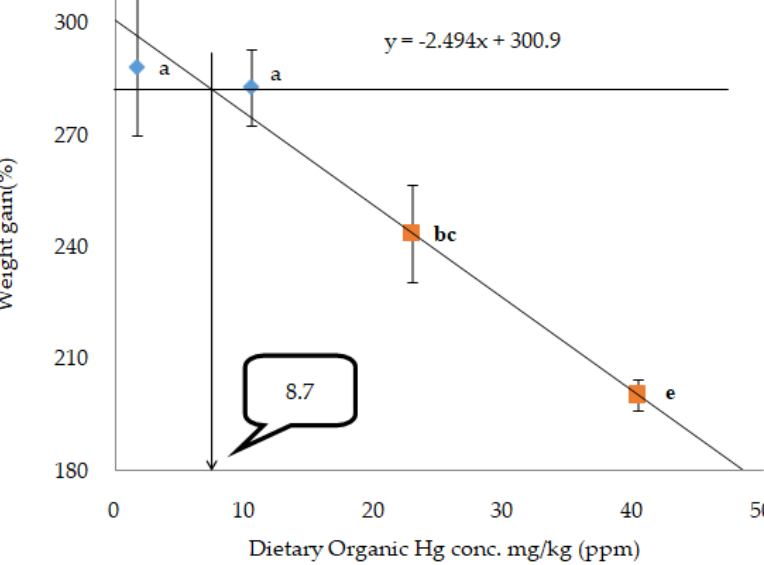
Figure 3. Broken-line analysis of weight gain (%) in olive flounder fed different levels of dietary organic mercury (MeHg) for eight weeks.